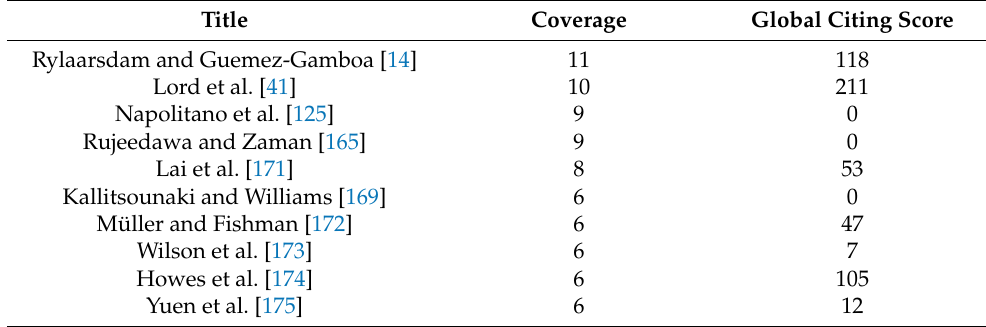
Table 11. Top 10 citing papers in Cluster #8 identified using DCA.